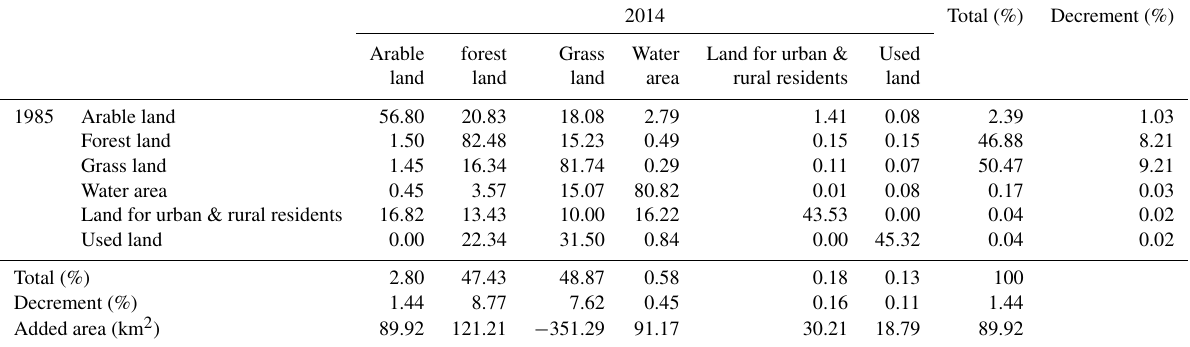
Table 1. Land use conversion matrix from 1985 to